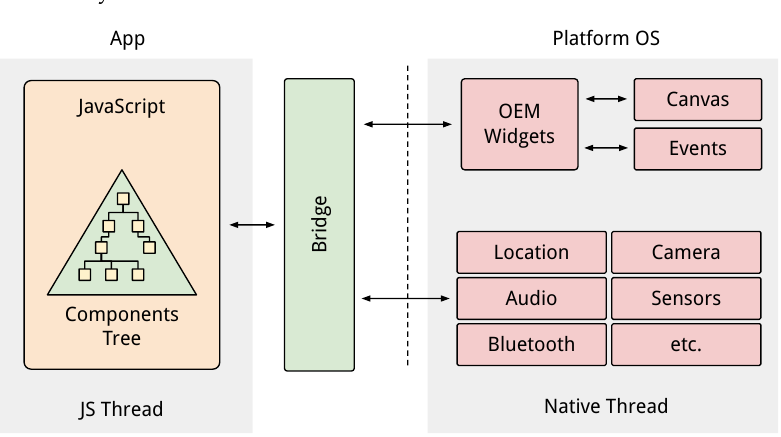
Figure 4. Overview of the React Native